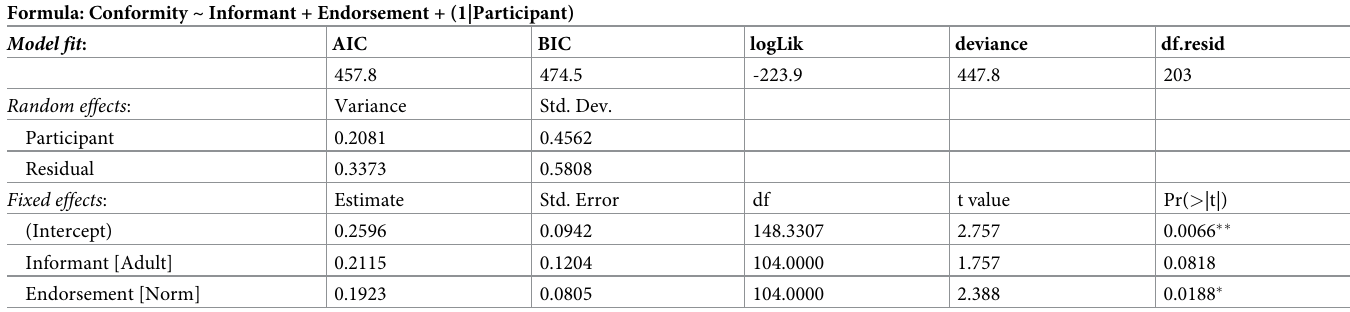
Table 1. Summary of the linear mixed effects model of conformity as predicted by informant (child, adult) and endorsement (preference, norm). Formula: Conformity ~ Informant + Endorsement +